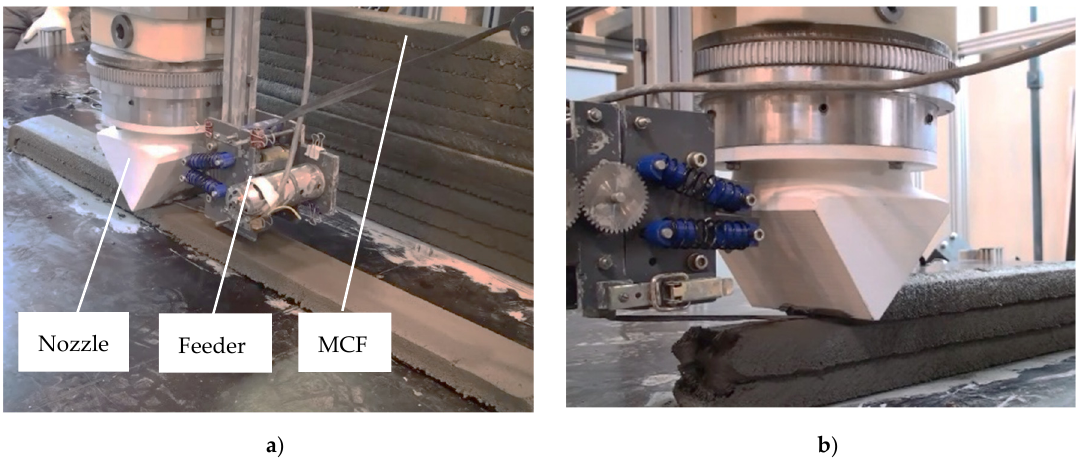
Figure 9. Printing of carbon reinforced concrete walls: ( a ) overview and ( b ) a detailed view of the nozzle with the MCF feeder.